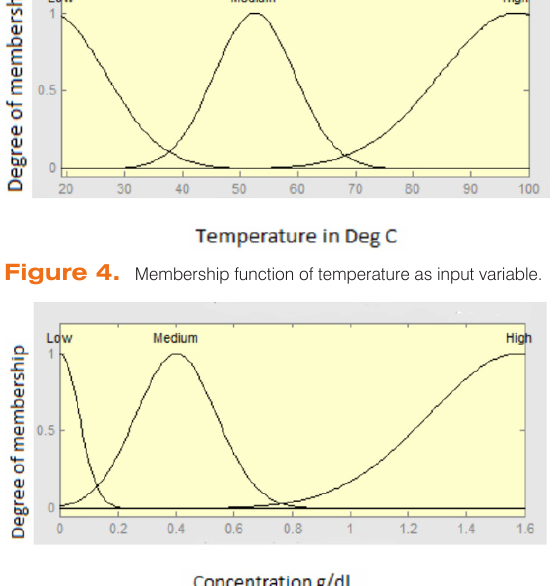
Figure 5. Membership function of concentration as input variable.